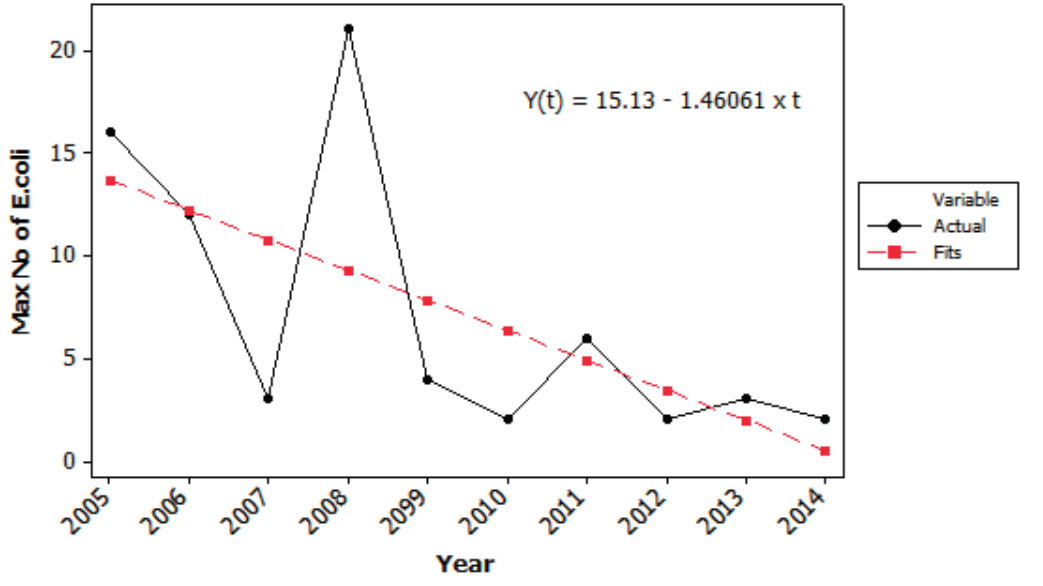
Figure 4. Maximum number of Escherichia coli (cfu/100 mL) detected in the raw water at Oset water treatment plant each year from 2005–2014. Data from the weekly routine samples (52 ± 2 samples each